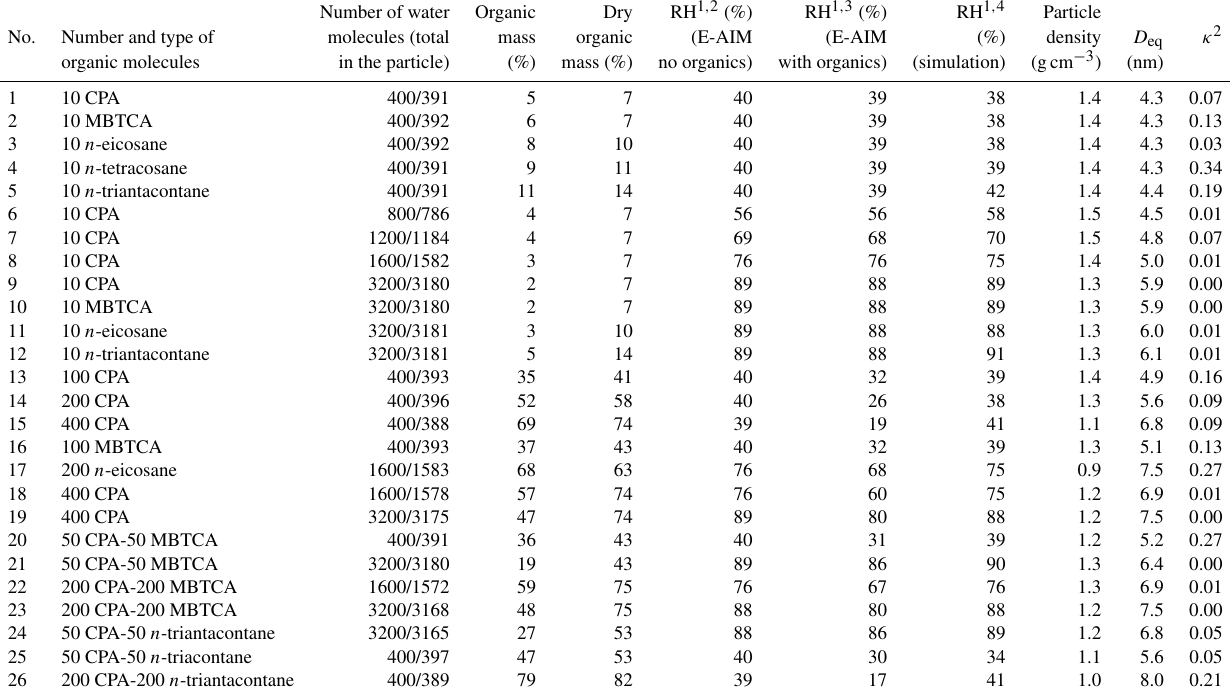
Table 1. Parameters and particle characteristics for the MD simulations. Number of water Organic